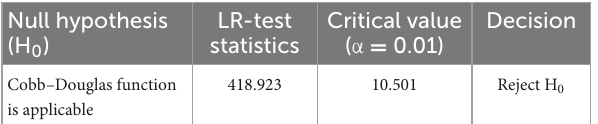
TABLE 5 Results of LR tests.